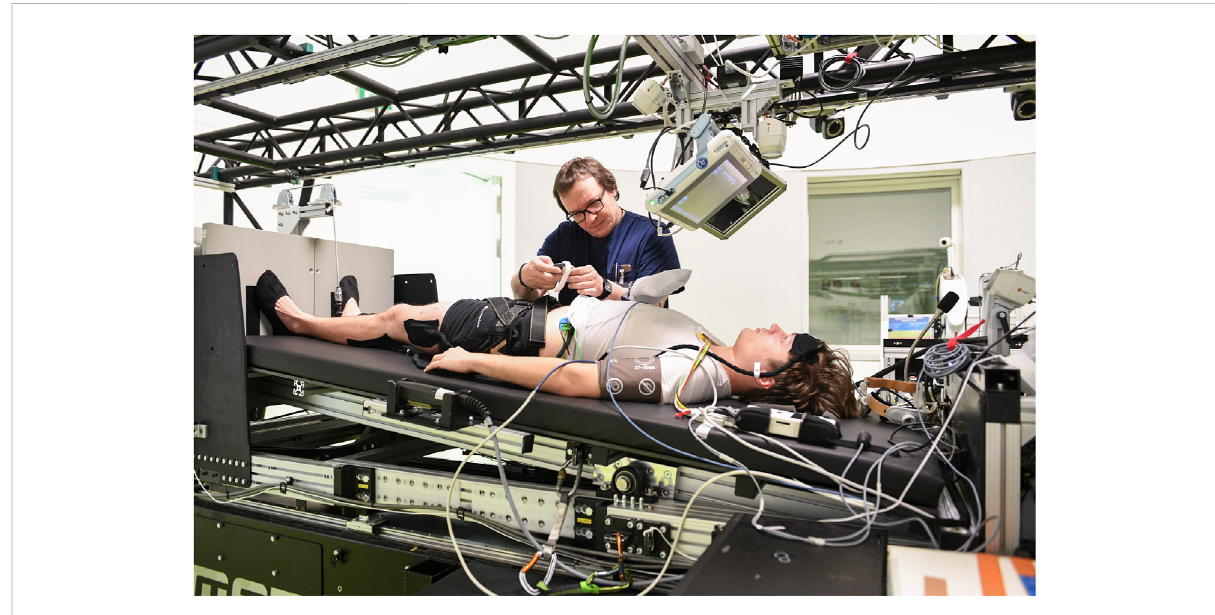
FIGURE 4 An operator is prepping a subject for a run on the DLR SAHC-1centrifuge. The subject is in HDT prior to centrifuge